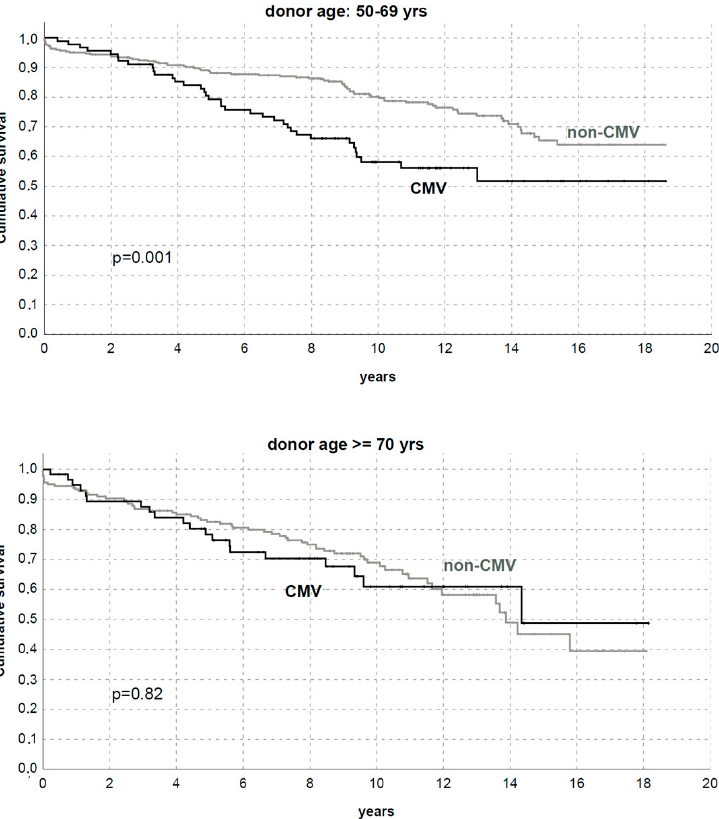
Figure 5. Death-censored graft survival by CMV replication/disease in the first year after transplantation with donors <50 years, 50–69 years, or ≥ 70 years.